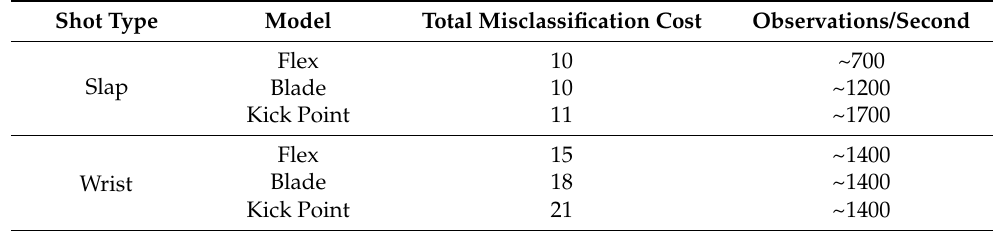
Table 8. Total misclassification cost and prediction speed of each of the six most accurate